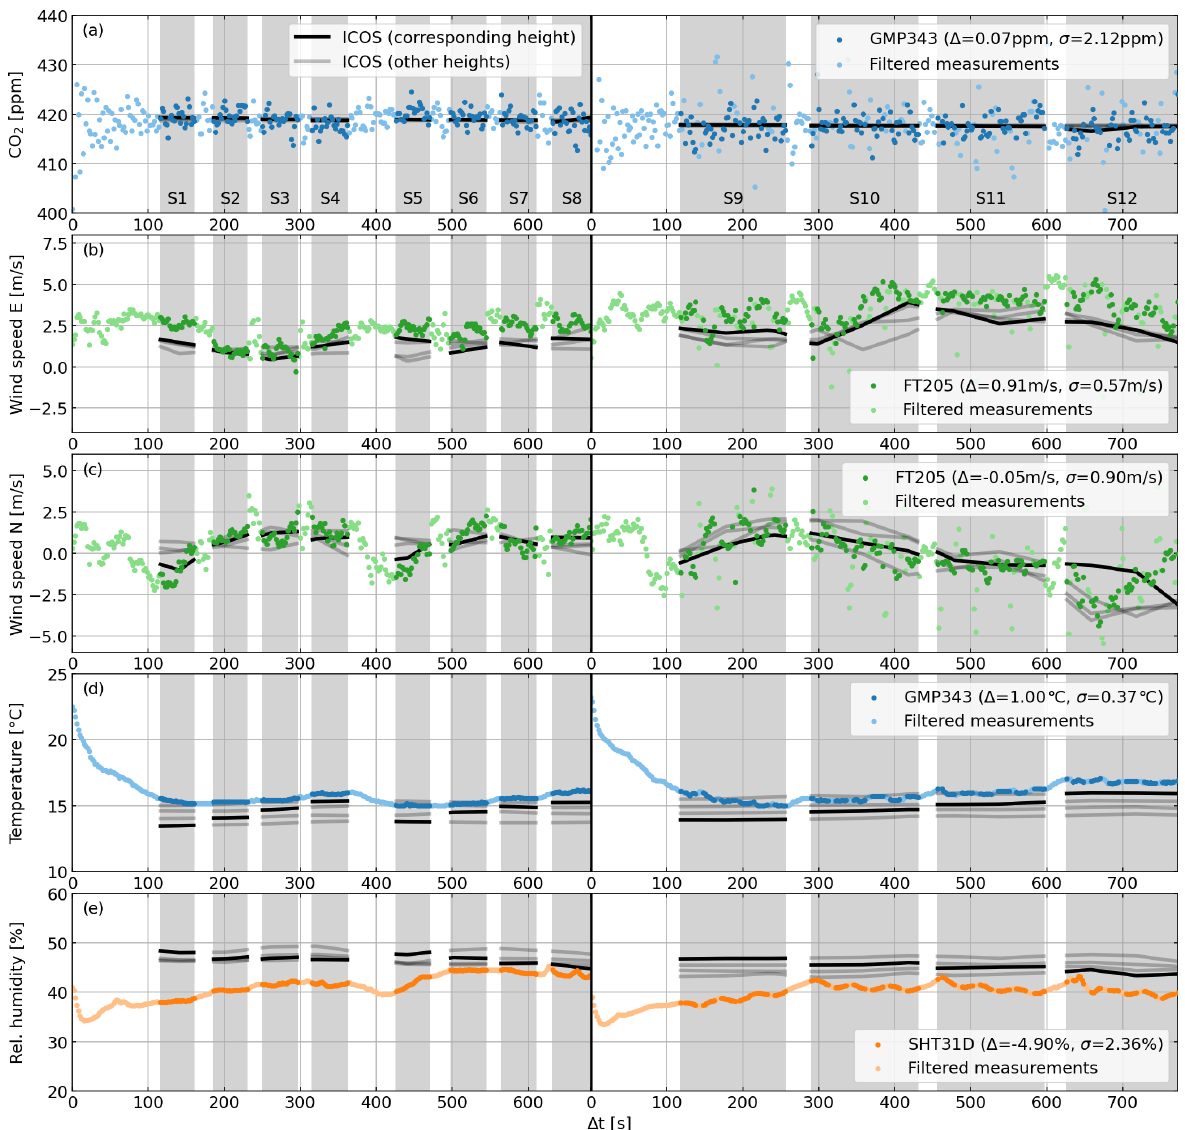
Figure 6. Measurements and results from the validation flights at the ICOS atmospheric station Steinkimmen (STE), Germany, 9 April 2020. From top to bottom: CO 2 mole fraction (a) , wind speed in the east direction (b) , wind speed in the north direction (c) , temperature (d) , relative humidity (e) . Left: flight 1. Right: flight 2. Gray areas correspond to measurement sequences S1–S12 during which the UAV visited one of the ICOS measurement levels. Light colors represent filtered measurement with a UAV acceleration larger than 0.1ms − 2 . Bold colors represent measurements used for the